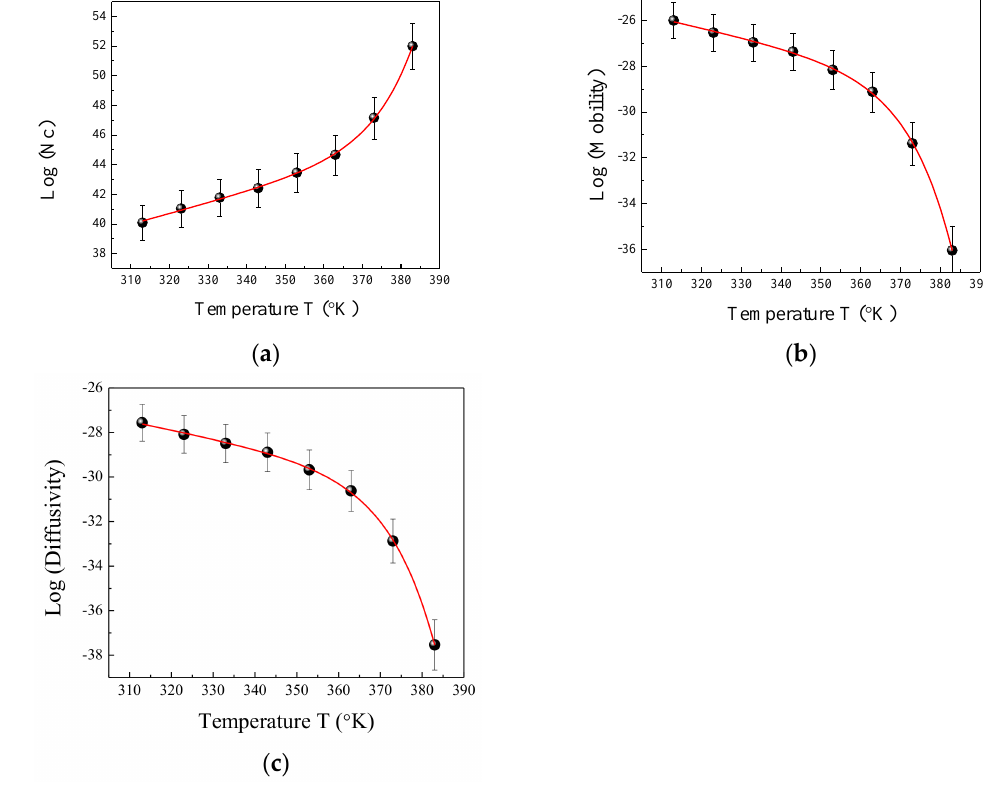
Figure 8. The log N i ( a ), log µ i ( b ) and log D i ( c ) for PVA/LiCl film as a function of